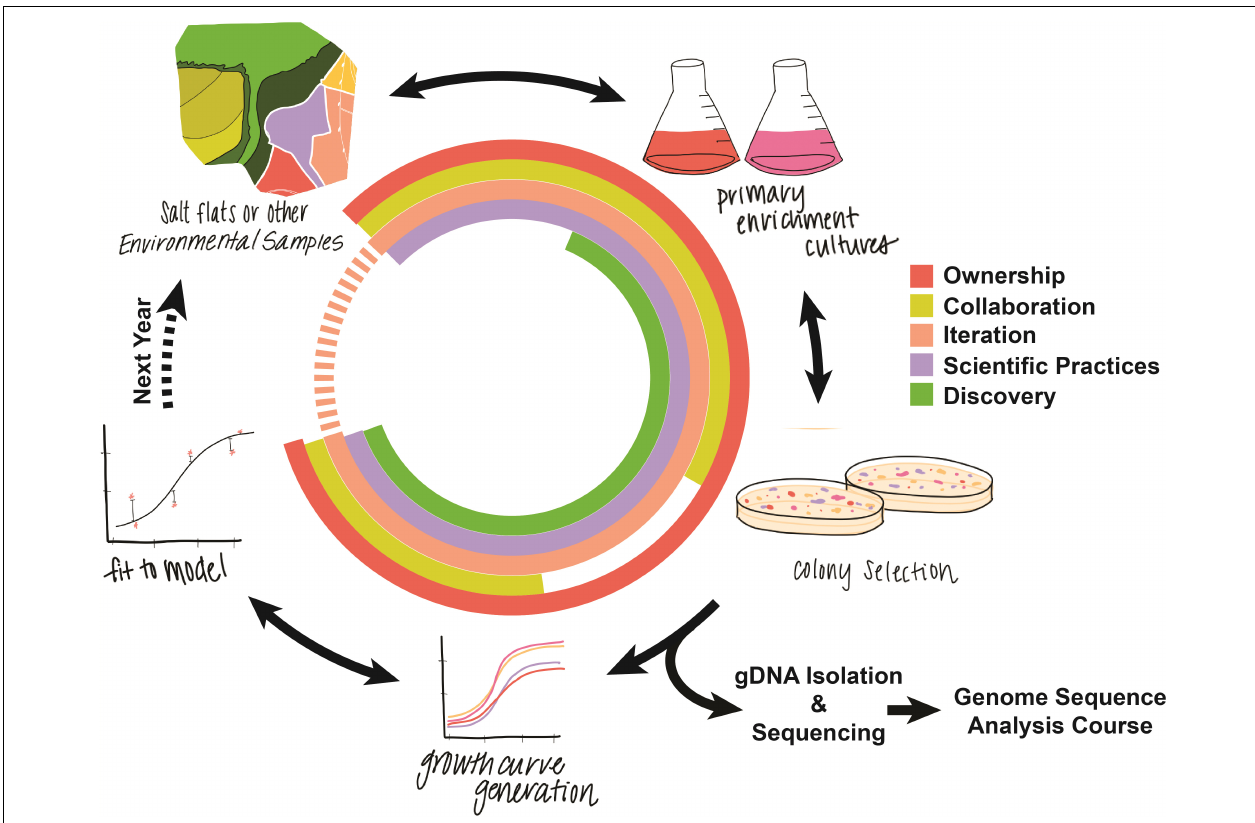
FIGURE 1 | Graphical overview of the course structure. Colors in the circle correspond to different core elements of course-based undergraduate research experiences. Arrows in both directions represent places where students can iteratively repeat and revise, for example re-plating primary enrichment cultures to look for novel colonies or fitting additional models to growth